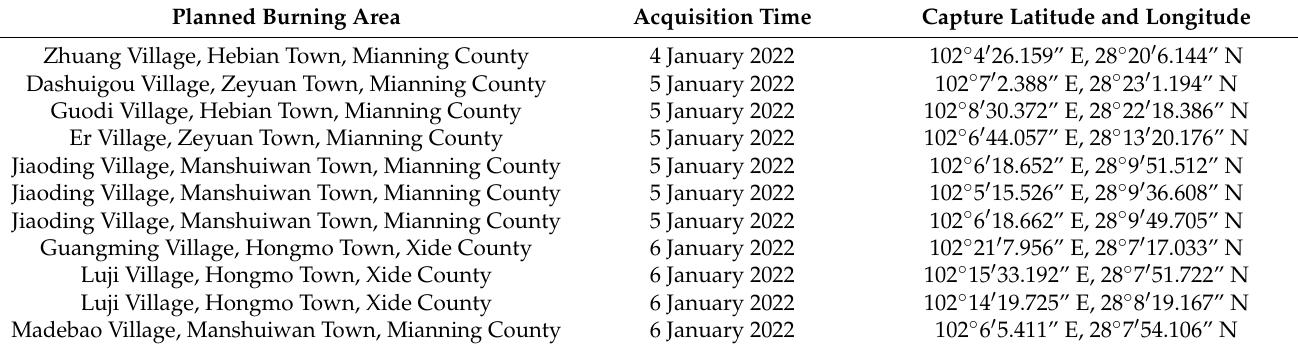
Table 2. Information of planned burning area.